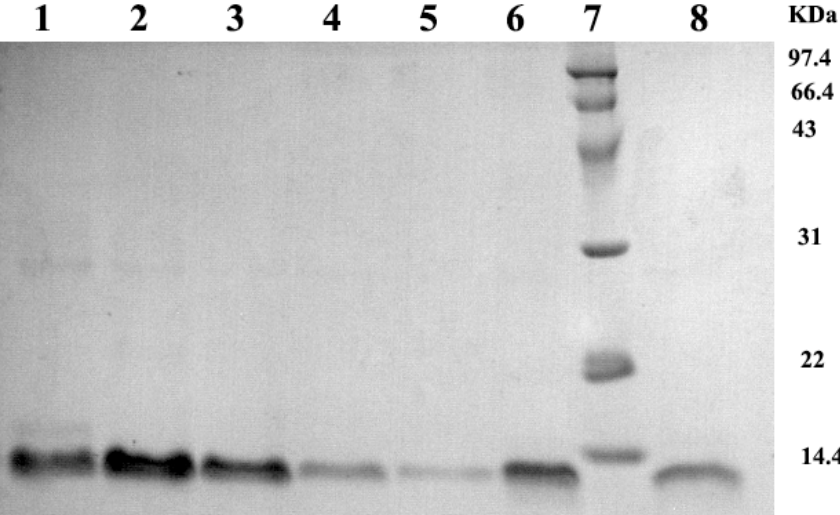
Figure 1. Analysis of purified pBD2 by SDS-PAGE. Lanes 1, 2, 3, 4, 5, 6, 8 indicate the purified protein from different collected tubes; Lane 7 indicates the protein marker.